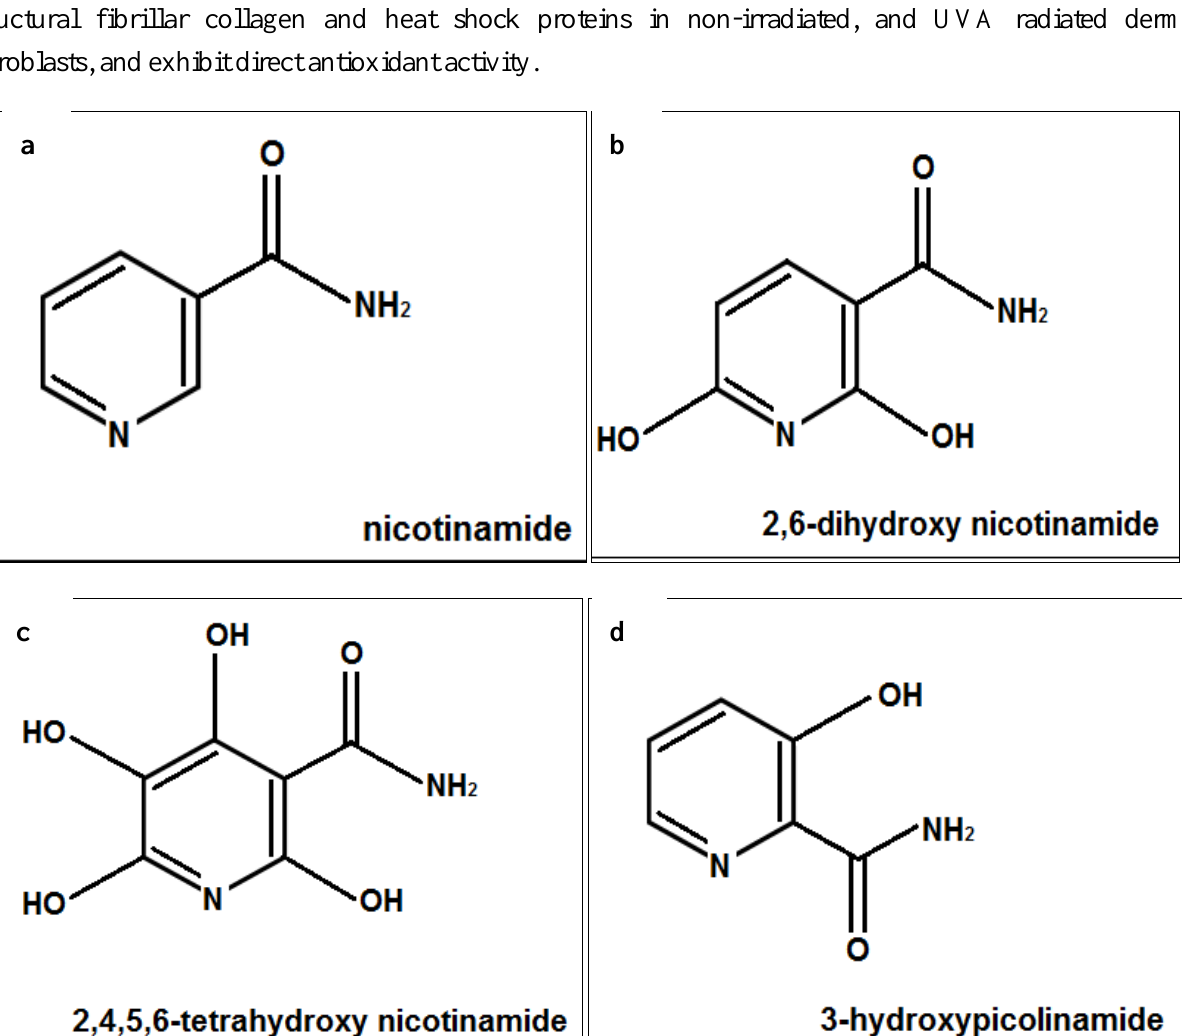
Figure 6. Structures of nicotinamide ( a ); 6-dihydroxynicotinamide ( b ); 2,4,5,6- tetrahydroxynicotinamide ( c ); and 3-hydroxypicolinamide ( d